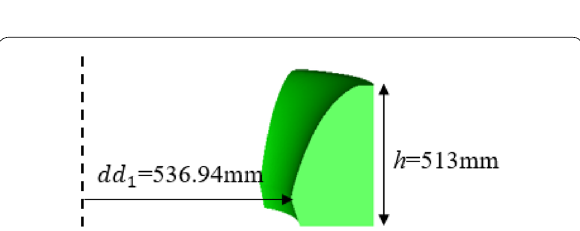
Figure 13 Suggested shape of the tractrix die with height of 513